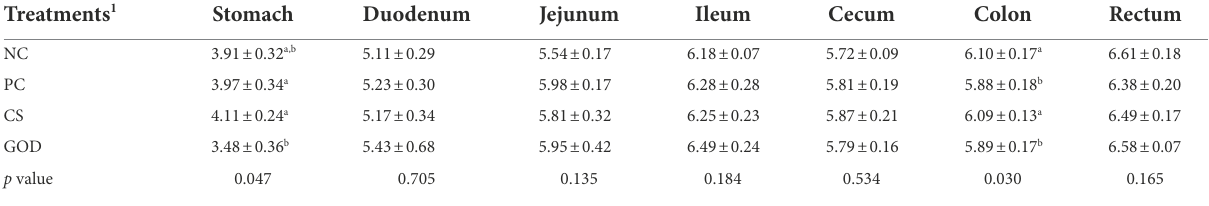
TABLE 6 Effect of dietary treatments on pH value of gastrointestinal tract in piglets challenged by enterotoxigenic Escherichia coli (ETEC). Treatments 1